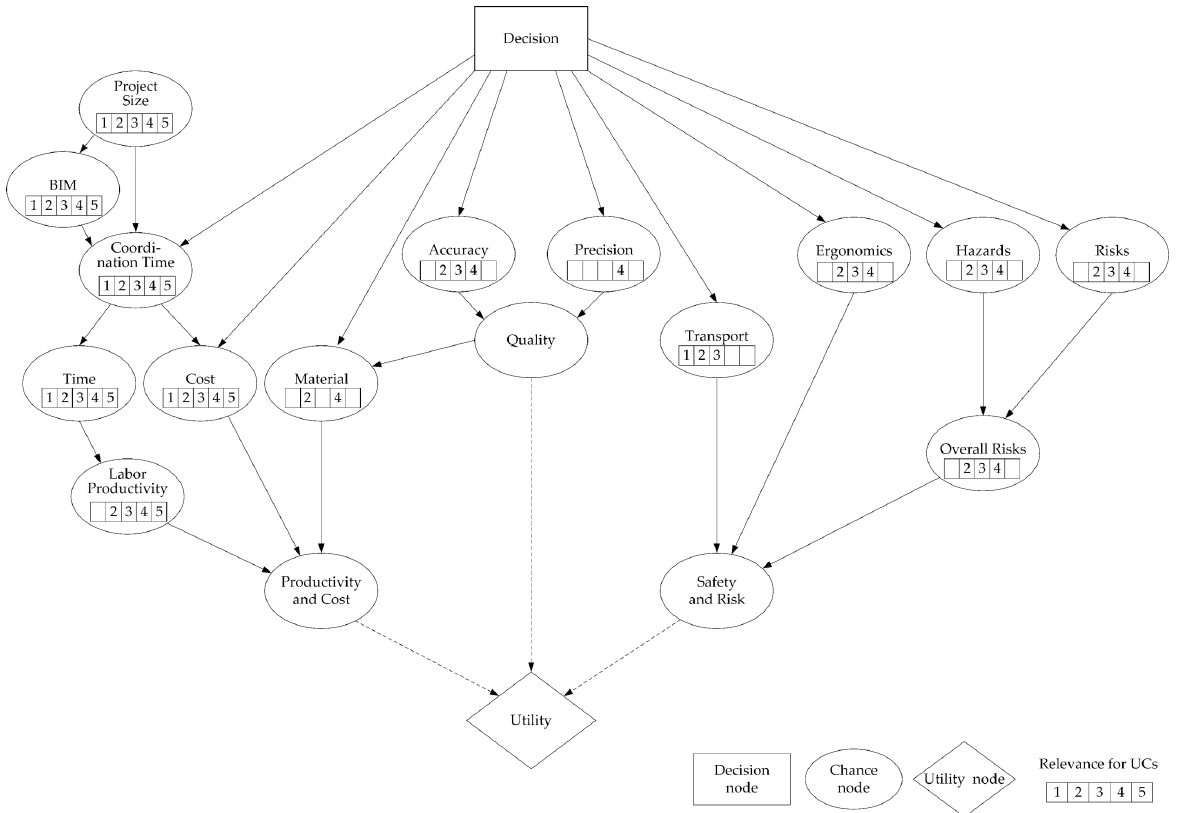
Figure 1. Decision model for UCs 1 to 5. Table 2. List of variables to be considered in the